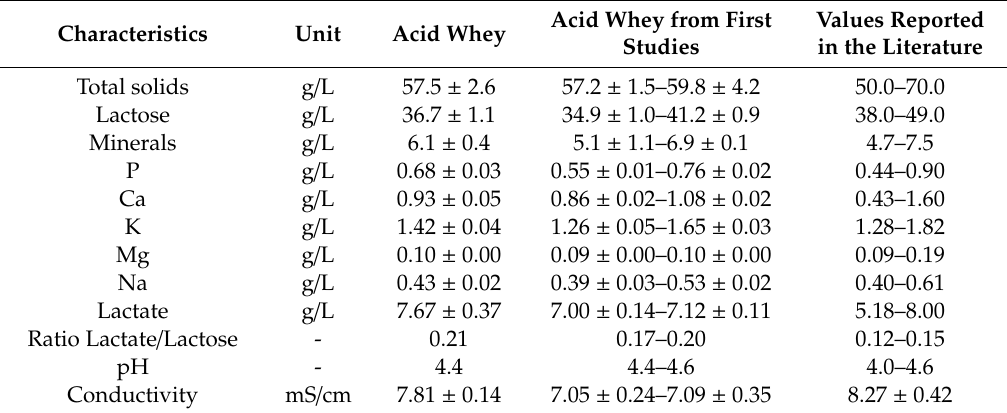
Table 1. Raw acid whey composition and physicochemical characteristics